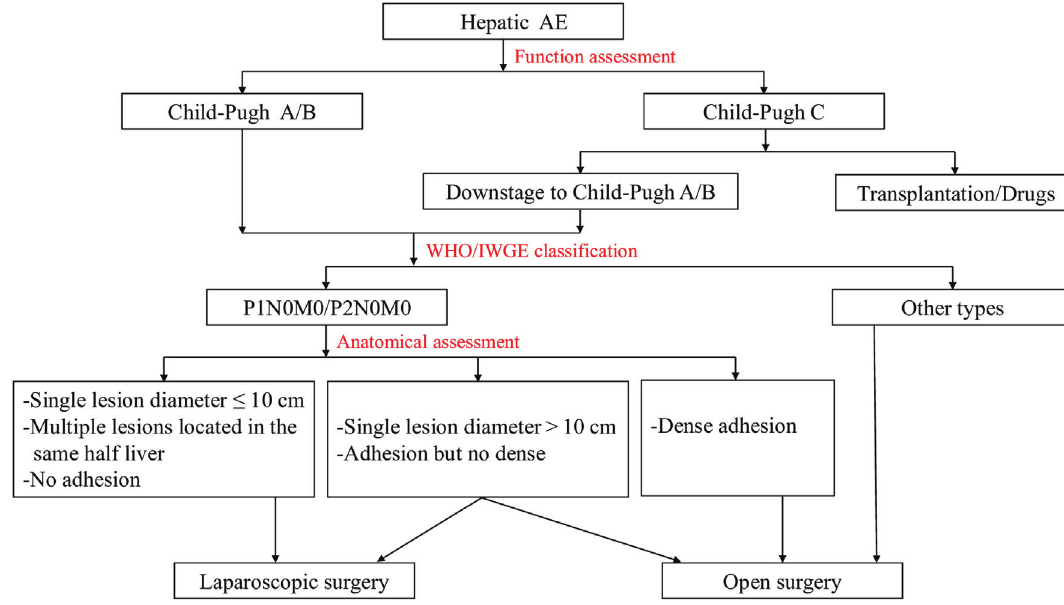
Figure 2. Treatment algorithms for hepatic alveolar